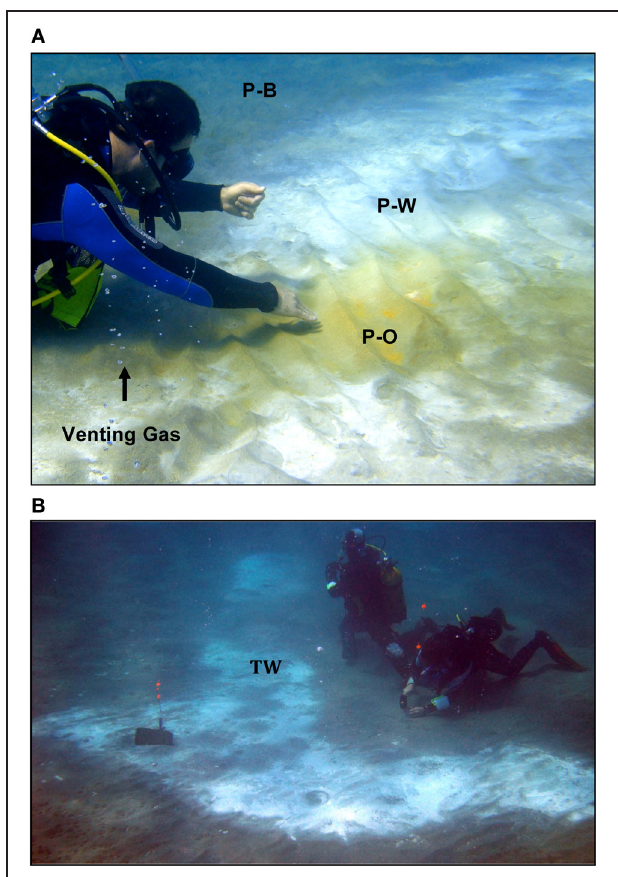
FIGURE 2 | (A) Photograph of the RP site investigated in this study. P-O, Palaeochori orange; P-W, Palaeochori white; and P-B, Palaeochori background. Geochemical profiles and sediment cores were sampled at ∼ P-W. (B) Photograph of the TW site. Geochemical and microbiological samples for this study are indicated at the location of